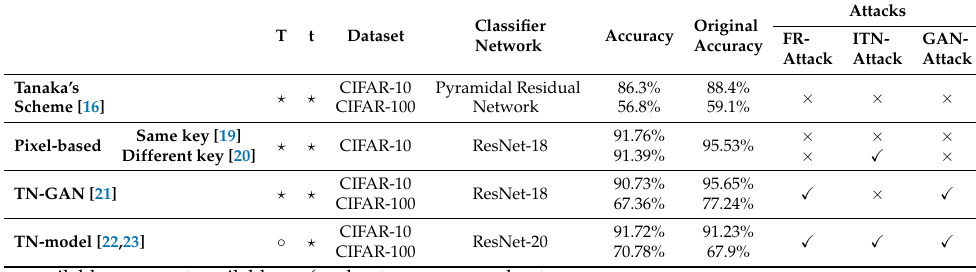
Table 2. Details and properties of the perceptual methods through the availability of the model training (T) and testing (t) using encrypted data, the dataset used, the classifier network used to classify the encrypted data, the accuracy of the classification, the accuracy of the original model (using simple images), and the robustness against various COA. T t Dataset Classifier Network Accuracy Original Accuracy